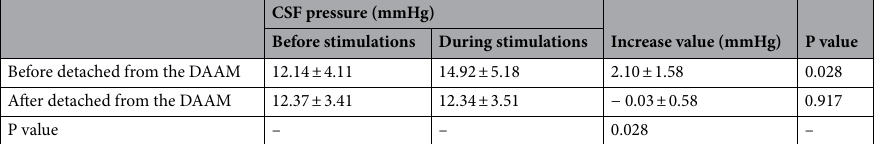
Table 2. The role of the myodural bridge in OCI affecting the CSF pressure (n = 6).